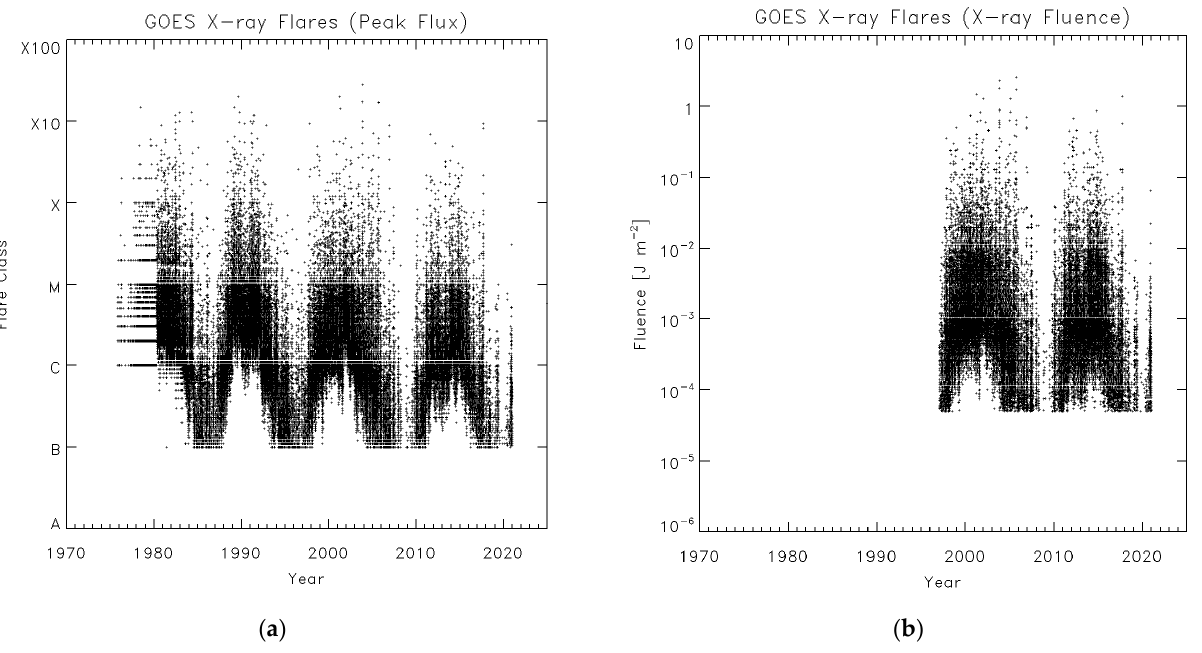
Figure 1. Solar soft X-ray flares detected by the Geostationary Operational Environmental Satellites (GOES): peak flux ( a ) and fluence of flares ( b ) as a function of year.